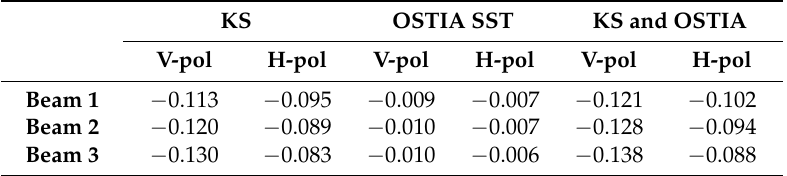
Table 2. Recalibration offset for Aquarius brightness temperatures in Kelvin applied when changing the dielectric constant model to Klein and Swift (KS) and/or the ancillary SST product to Operational Sea Surface Temperature and Sea Ice Analysis (OSTIA) in the retrieval